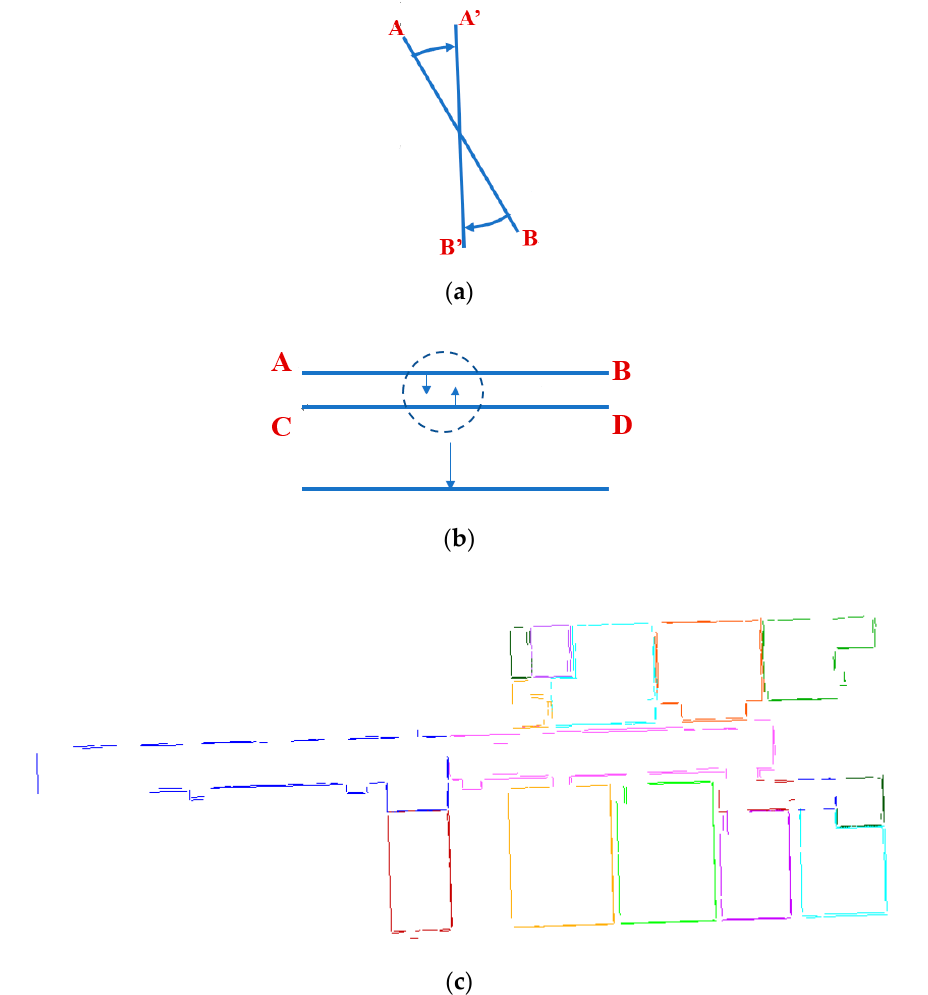
Figure 8. Global optimization of lines. ( a ) Correction of angle. ( b ) Correction of distance. ( c ) The global optimization results.